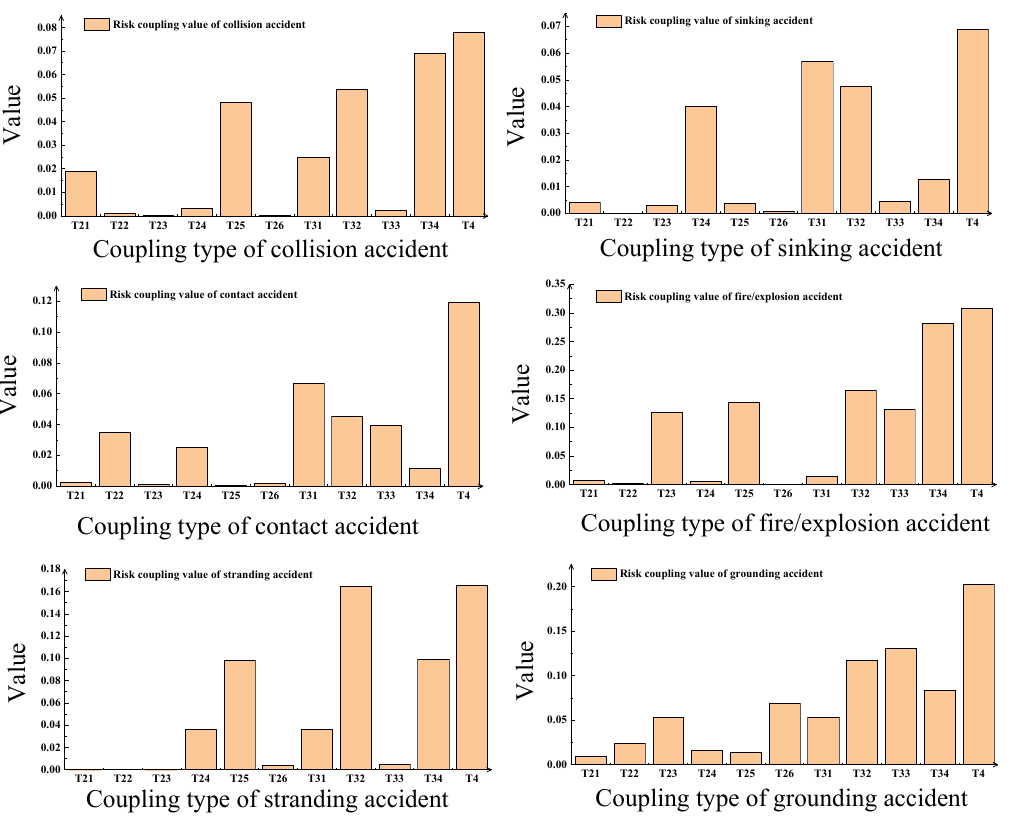
Figure 12. Risk coupling value of different types of accidents.